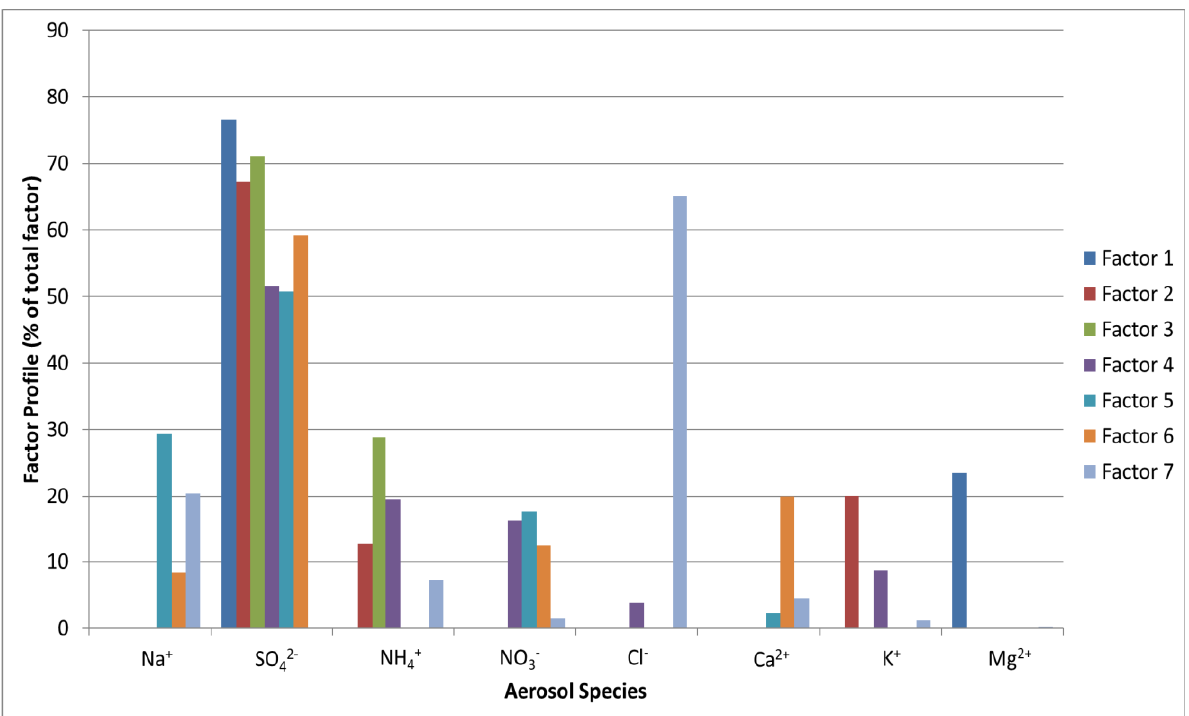
Figure 8. Relative contribution of various factors representing potential sources of water-soluble ionic species in aerosols collected at the study site.